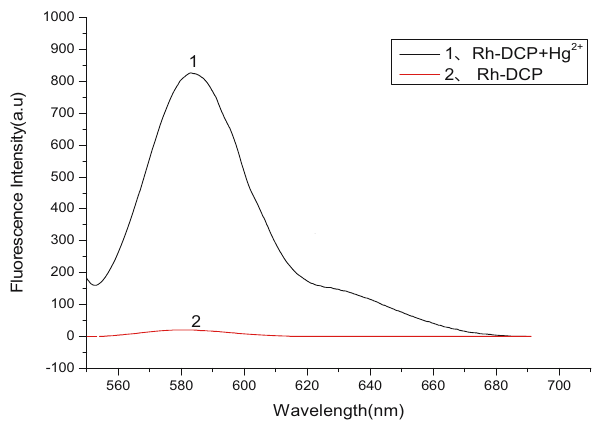
Figure 2: Fluorescence spectrum of rhodamine class B derivatives and Hg 2 + fl uorescence systems ( CH 3 CH 2 OH/H 2 O [ v/v, 1/2 ] , λ = 530 nm, probe concentration 10 × 10 − 5 mol · L − 1 , Hg 2 + ex concentration 10 × 10 − 5 mol · L − 1 ) .